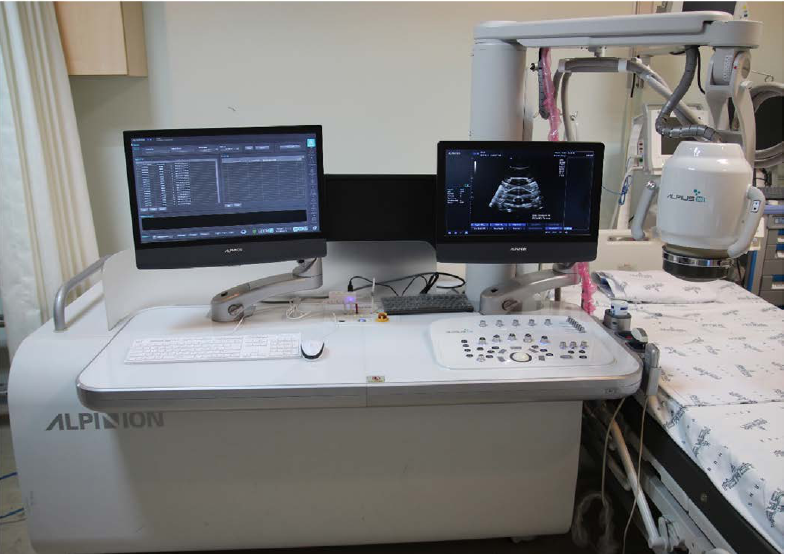
Figure 5. Alpius 900 system contained with the relatively small dimensions of 1.8 × 1.2 × 1.6 m 3 for portability and streamlined workflow on a treatment table